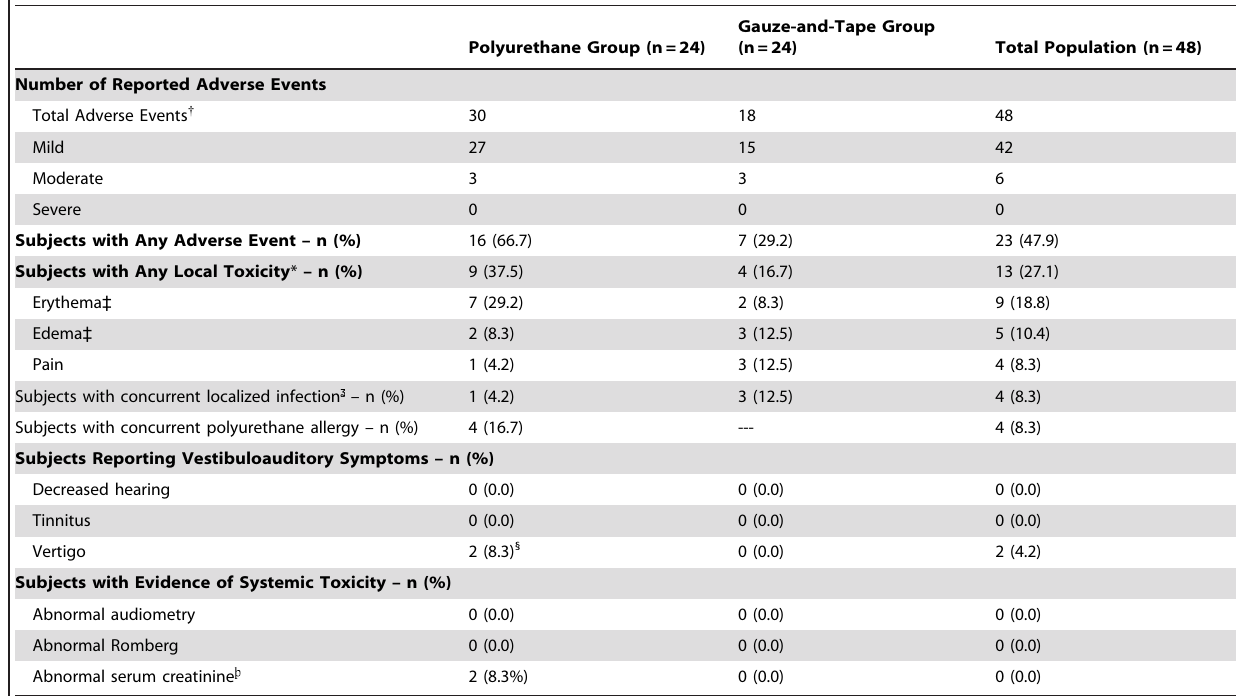
Table 6. Summary of Adverse